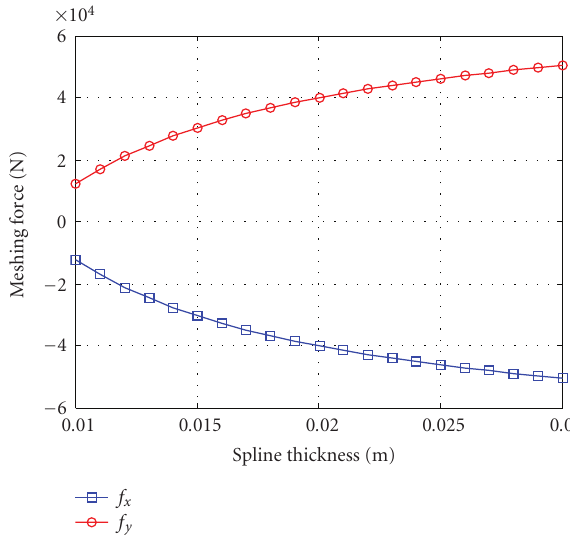
Figure 6: Meshing forces versus dynamic vibration displacement.